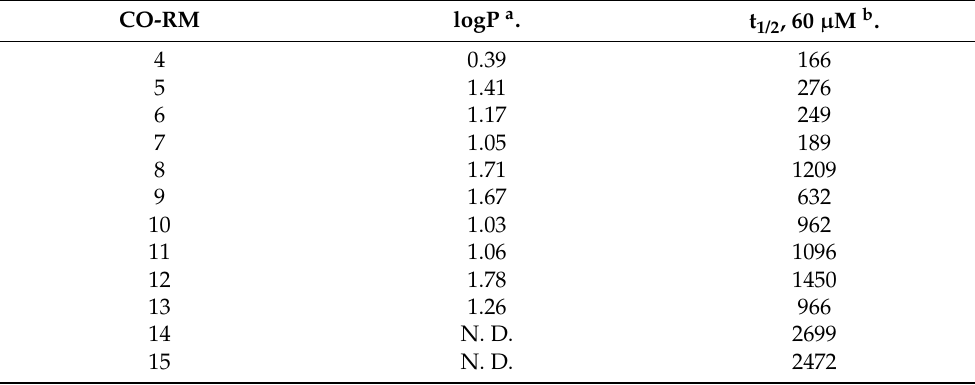
Table 2. The Correlation of Hydrophilicity and CO releasing kinetics of CO-RM. CO-RM logP a . t 1/2 , 60 µ M b . 4 0.39 166 5 1.41 276